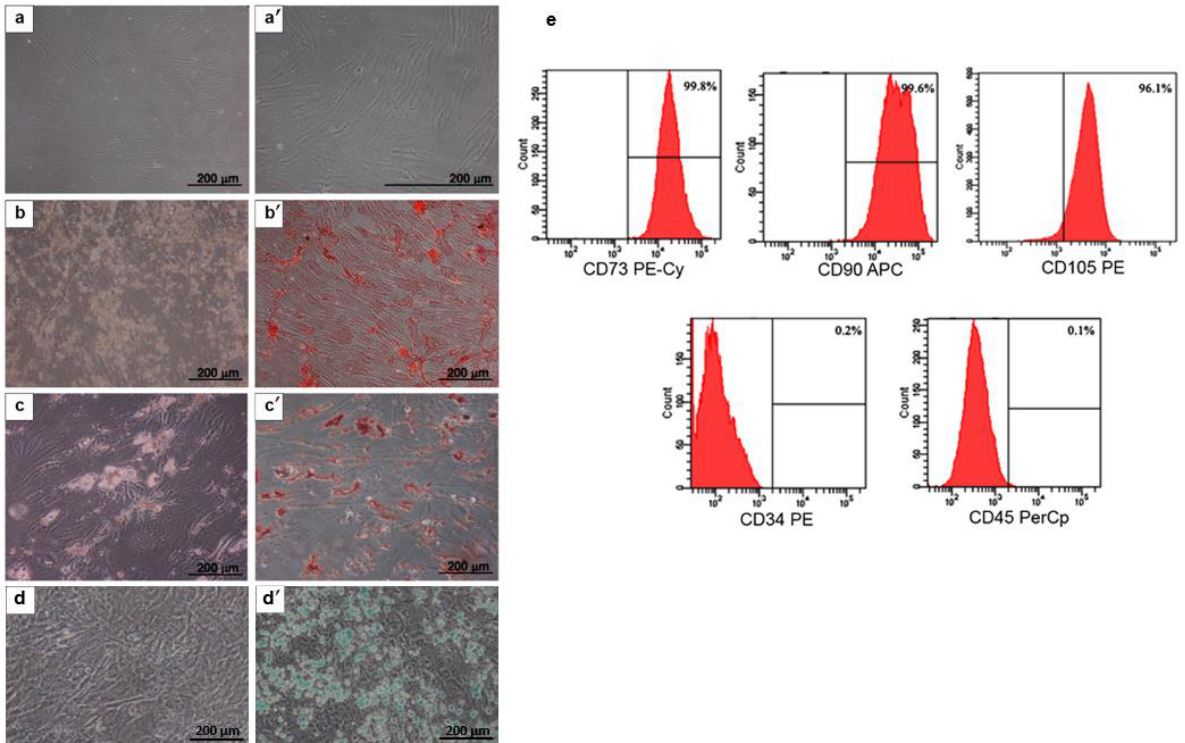
Figure 1. Characterization of human bone marrow mesenchymal stem cells (MSCs). The MSCs show a fibroblast-like morphology ( a , a (cid:48) ). MSCs were cultured in ODM ( b ) and stained with ARS ( b (cid:48) ). MSCs were cultured in ADM ( c ) and stained with Oil Red O ( c (cid:48) ). MSCs were cultured in CDM ( d ) and stained with Alcian blue ( d (cid:48) ). The phenotypic expression of CD34, CD45, CD73, CD90, and CD105 on the MSC surface were evaluated by flow cytometry ( e